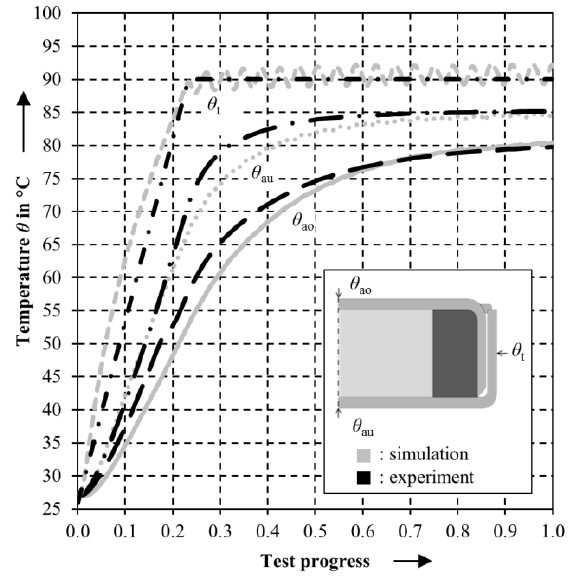
Figure 7. Comparison of experimental and simulated temperatures θ with d c = 22.5 mm. Positions: actuator top (ao), actuator bottom (au), and target temperature (t).